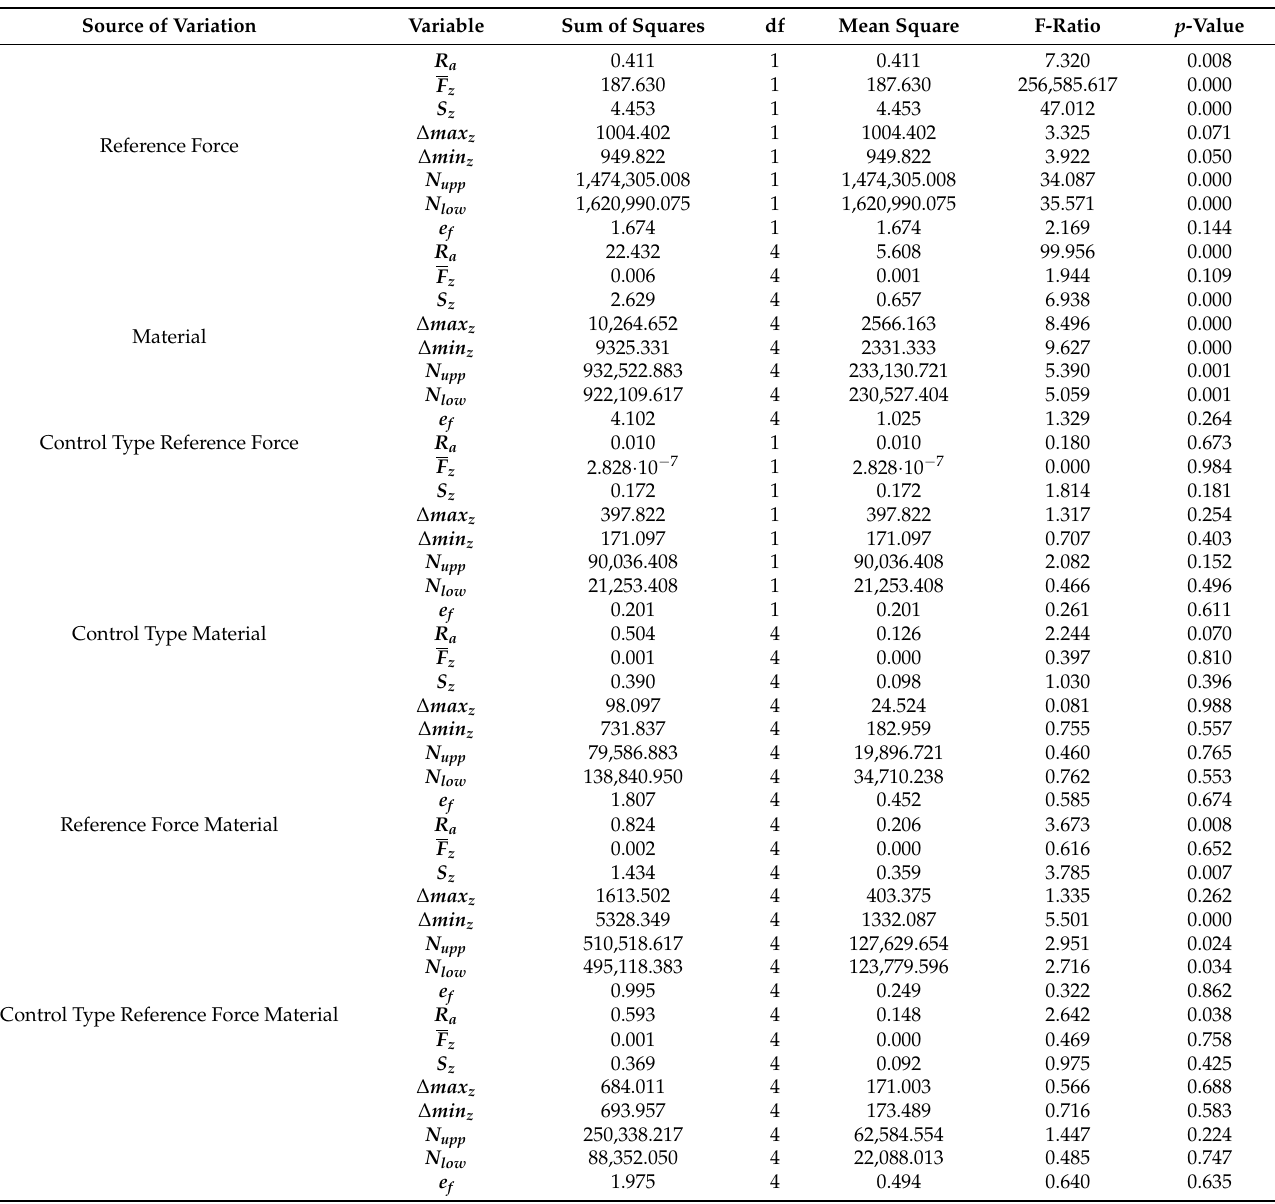
Table 4. ANOVA results (part